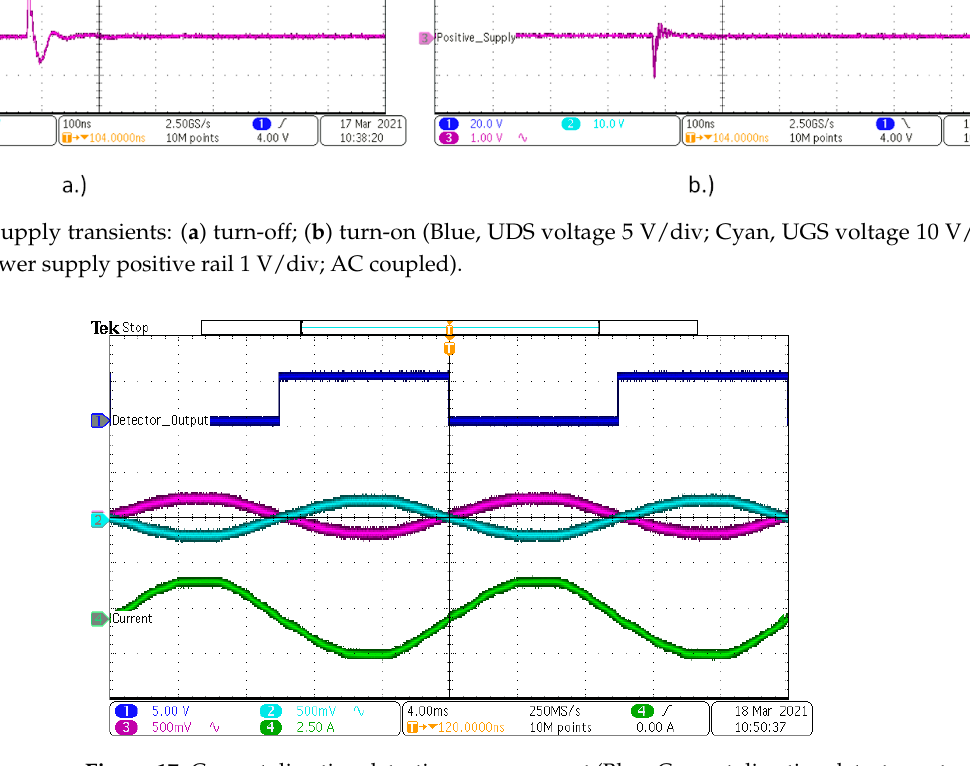
Figure 18. Current direction detection measurement (Blue, Current direction detector output 5 V/div; Green, Circuit current 500 mA/div).